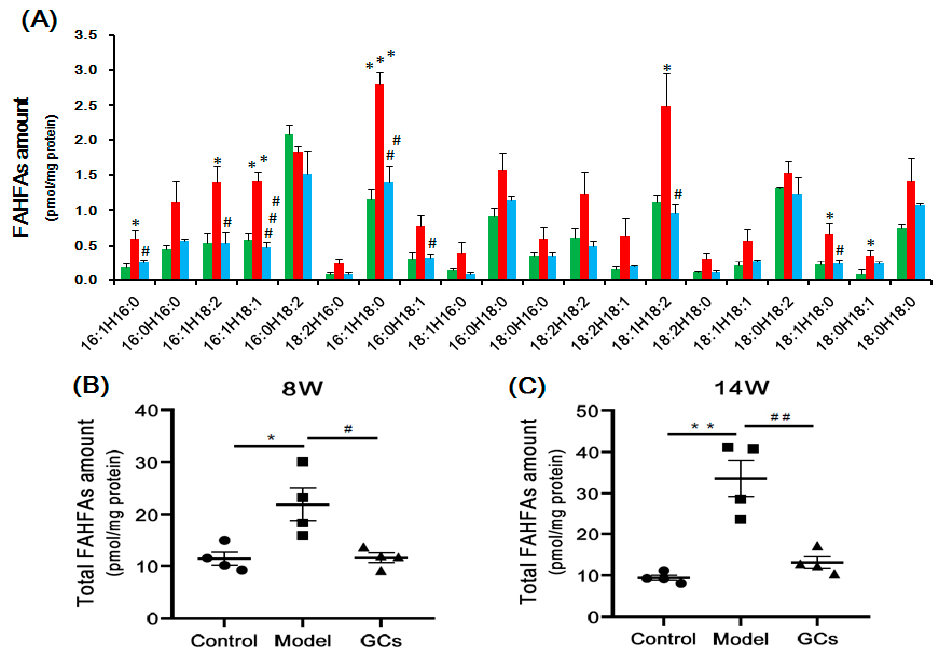
Figure 6. Comparison of the mass levels of fatty acid esters of hydroxy fatty acids in renal tissues from MRL/lpr mice at pre-lupus nephritis (LN) and LN state. The kidney samples of the control ( n = 4, green), model ( n = 4, red), and GCs ( n = 4, blue) groups were collected at 8- (pre-LN) and 14-weeks age (LN), respectively. The levels of individual fatty acid esters of hydroxy fatty acid (FAHFAs) species (Panel A ) in lipid extracts of kidney samples of mice from different groups at pre-LN state were determined with the MDMS-SL technology. Panels B and C represent the total amounts of FAHFAs in renal lipid extract from mice of different group at pre-LN and LN state, respectively. The filled circle, square and triangle represent the control, model, and GCs group, respectively. The data present means ± SEM from different groups. * p < 0.05, ** p < 0.01, and *** p < 0.001 compared with those in the control group. # p < 0.05, ## p < 0.01, ### p < 0.001 compared with those in the model group.